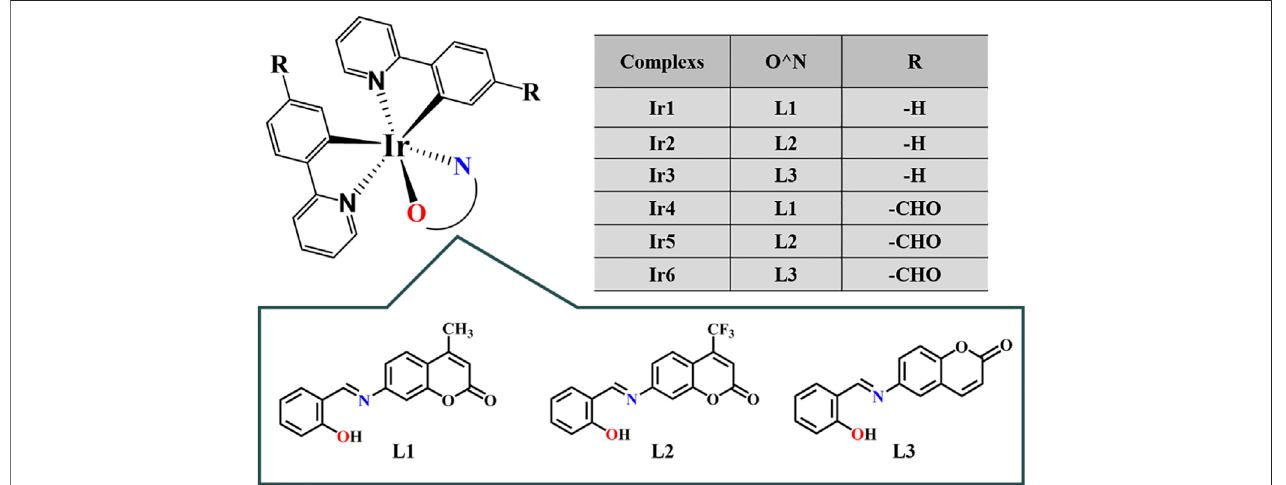
FIGURE 1 | Structures of coumarin-modi fi ed cyclometallic Ir Ⅲ Schiff base complexes.